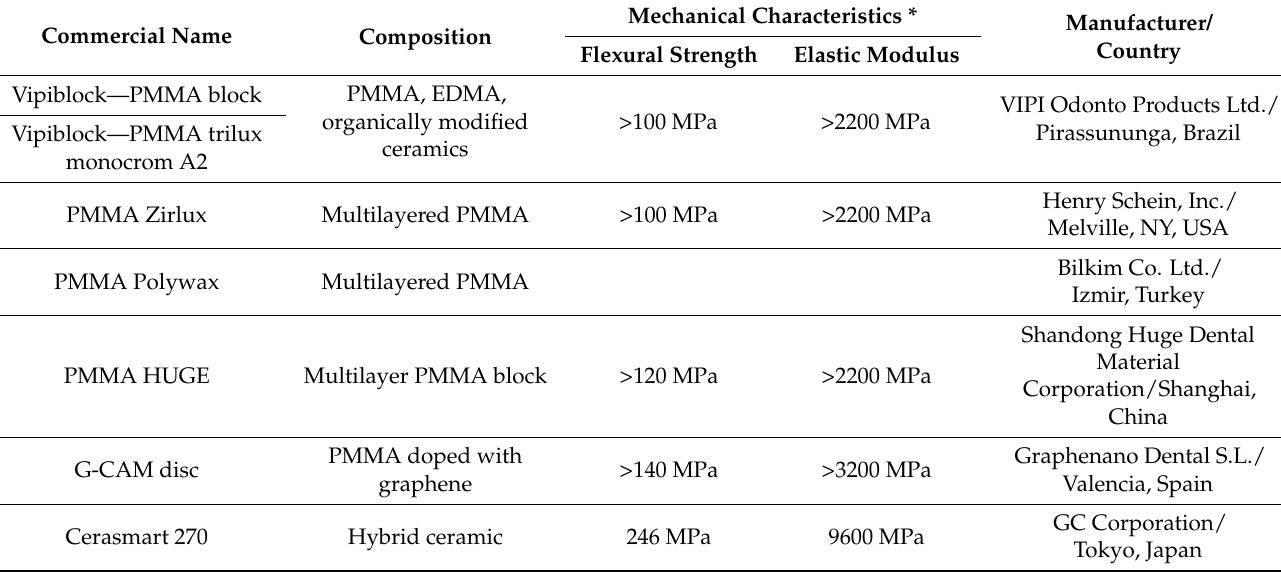
Table 1. General characteristics of materials employed in the